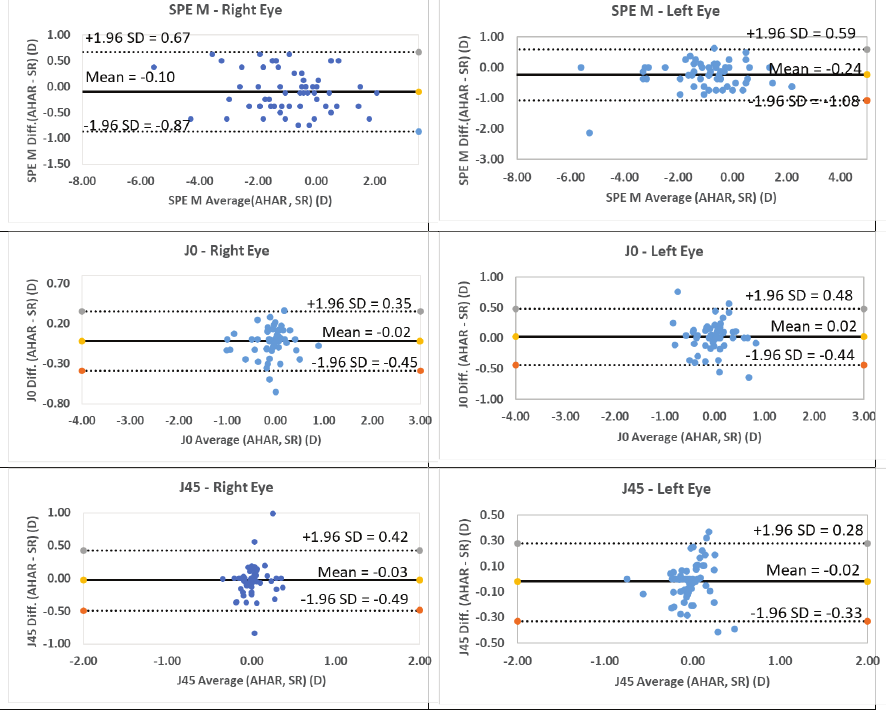
Figure 1. The Bland-Altman plots for comparing the SR and AHAR observations in the right and left eyes for SPE. 95% limits of the agreement are indicated by the upper and lower dashed line, and the mean is indicated by a solid